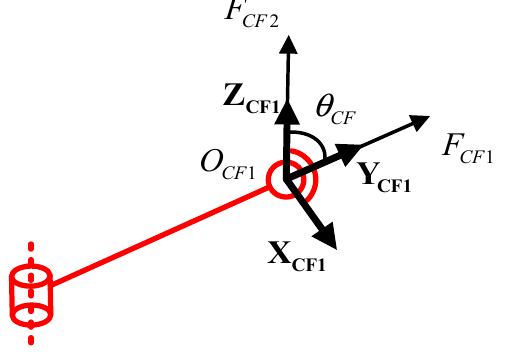
Figure 13. Analysis of constraint forces of the central branch.